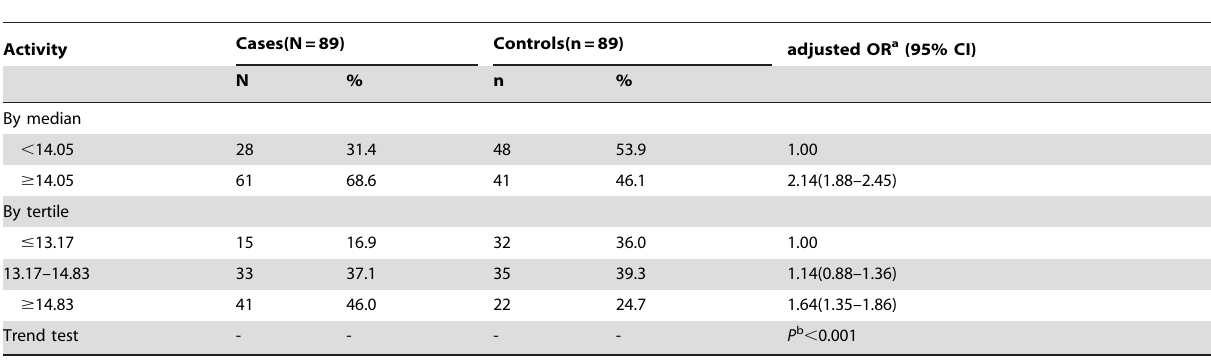
Table 5. Logistic regression analysis of iNOS activity in vitiligo patients and controls.